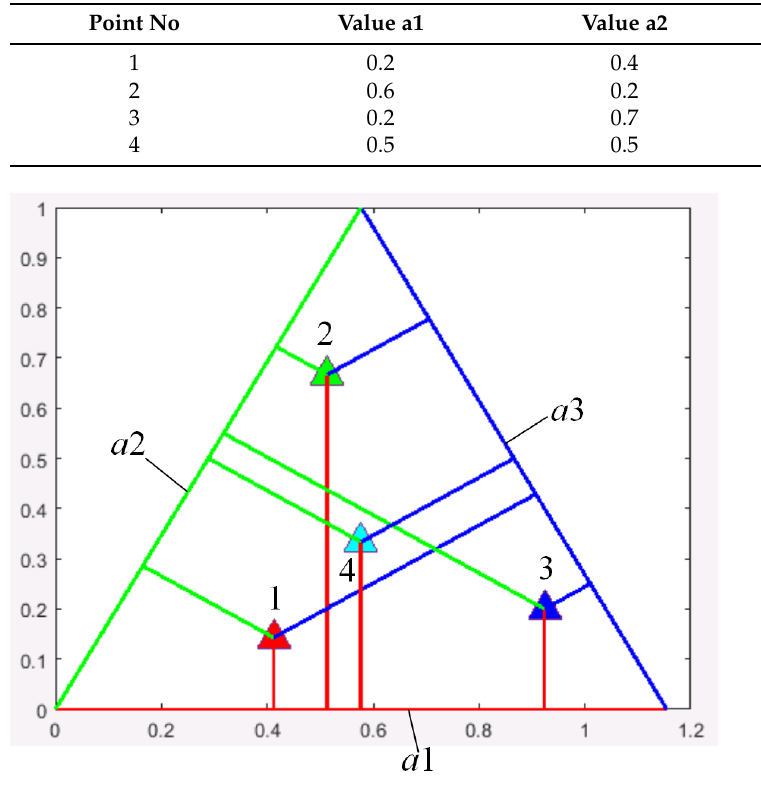
Figure A1. Rendering four values in